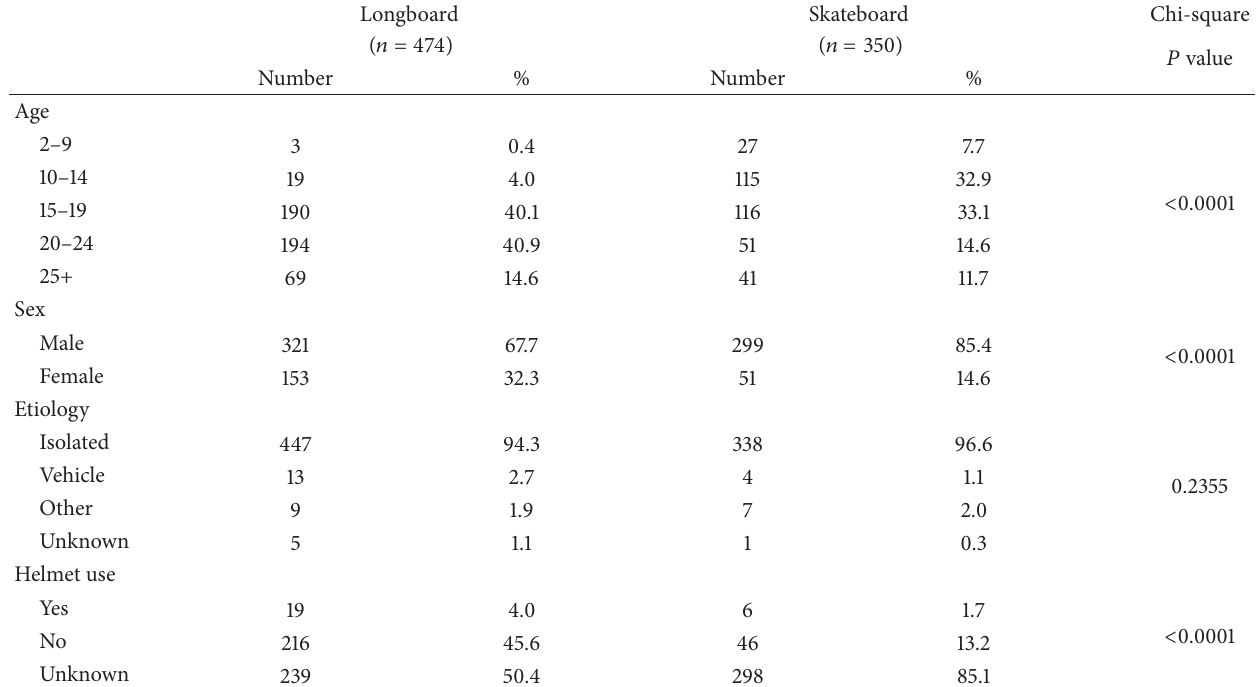
Table 1: Longboard/skateboard status according to selected variables.